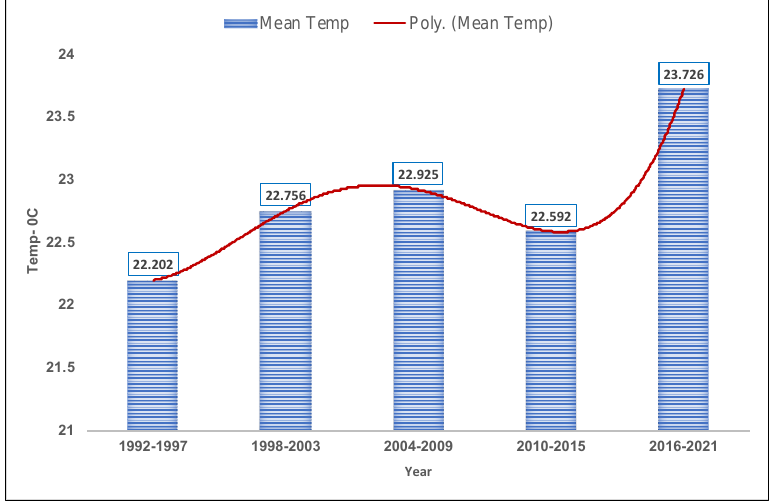
Figure 10. Trend analysis: temperatures (1992 – 2021).